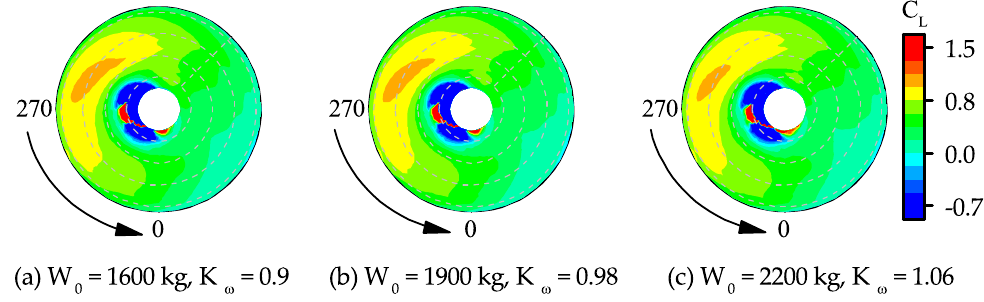
Figure 10. µ = 0.3, lift coefficient, C L , with rotor speed.